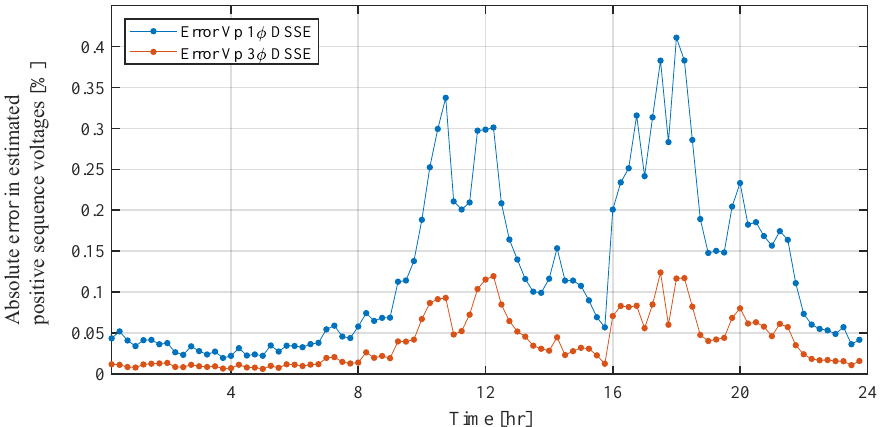
Figure 5. Plot of grid states of ( a ) individual phase voltages by 3 φ DSSE algorithm compared with their true values; ( b ) positive-sequence voltages by 1 φ DSSE algorithm.